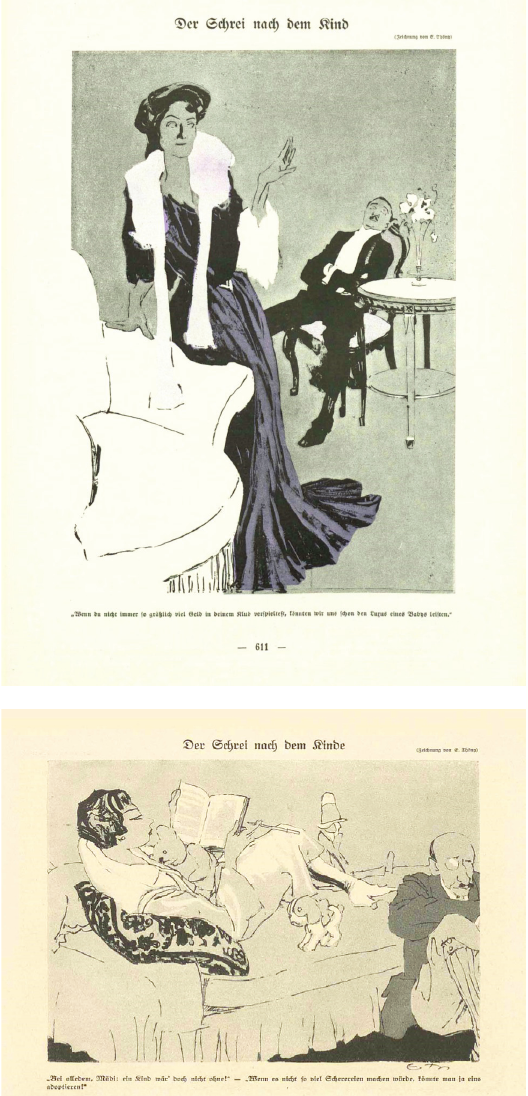
Figure 8, 9. Simplicissimus , 9 December 1907, p. 611 and 13 February 1928, p. 619. Images courtesy of Herzogin Anna Amalia Bibliothek Weimar; with kind permission of Dr. Dagmar von Kessel,